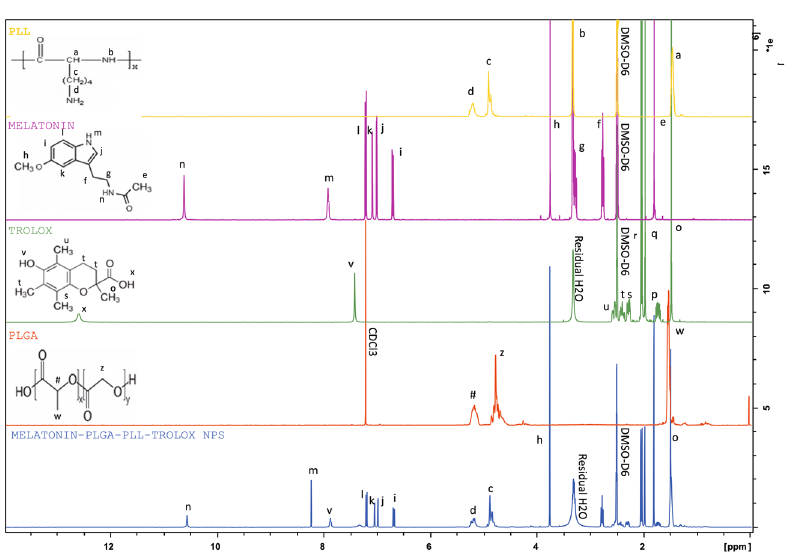
Figure 4. 1 H-NMR to characterize melatonin, PLGA, PLL and Trolox in PolyRad nanoparticles. 1 H-NMR spectra acquired at room temperature for PLL, melatonin, Trolox, PLGA and melatonin-PLGA-PLL-Trolox nanoparticles to confirm the nanoparticle